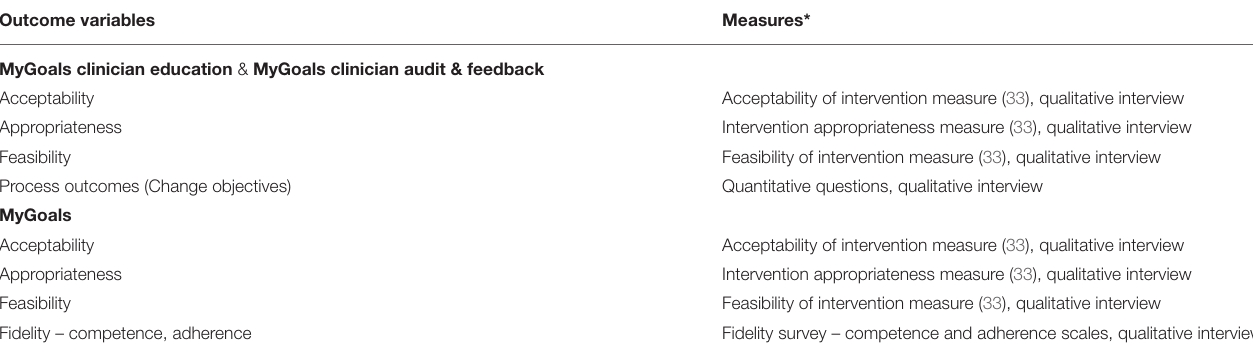
TABLE 3 | Selected outcome variables, measures, respondent, and measurement time